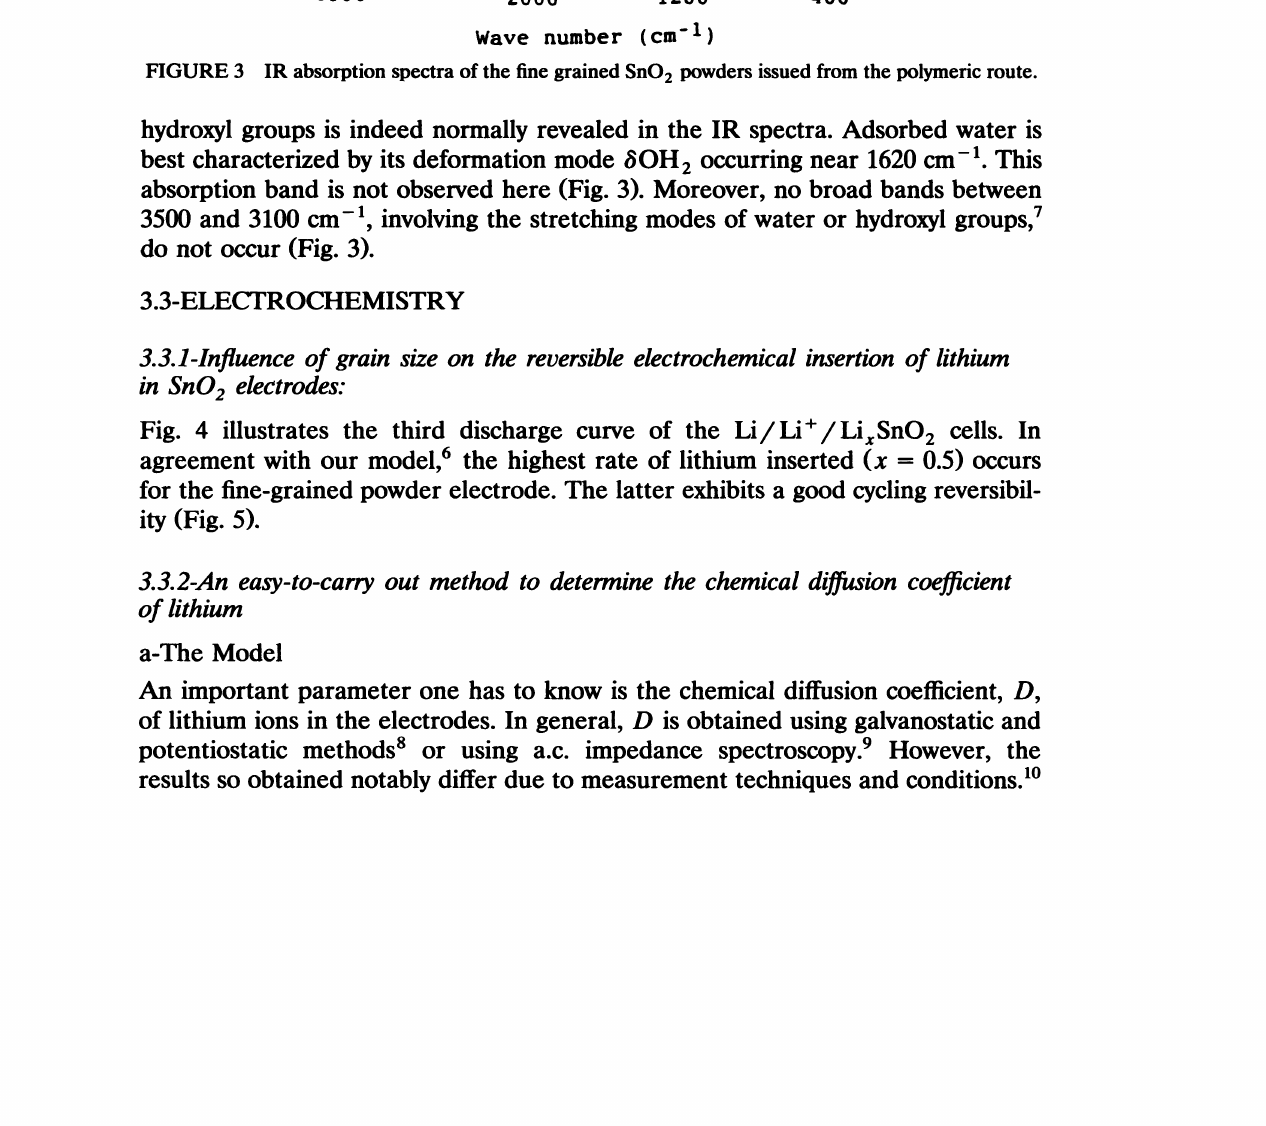
powders issued from the polymeric 2